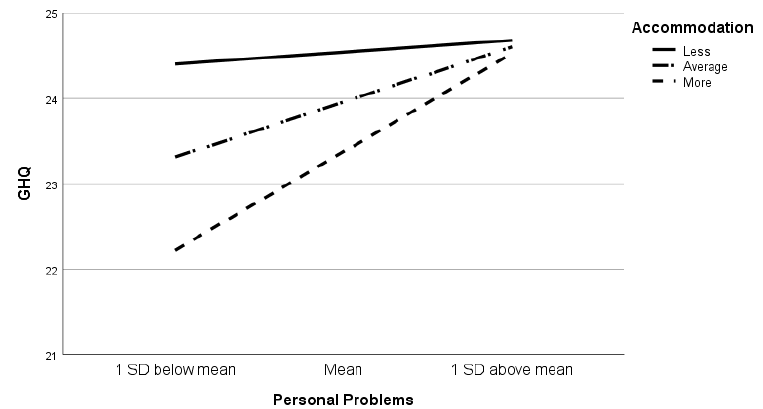
Figure 1. Slope graph testing the interaction between accommodation and personal problems on psychological well-being (GHQ).